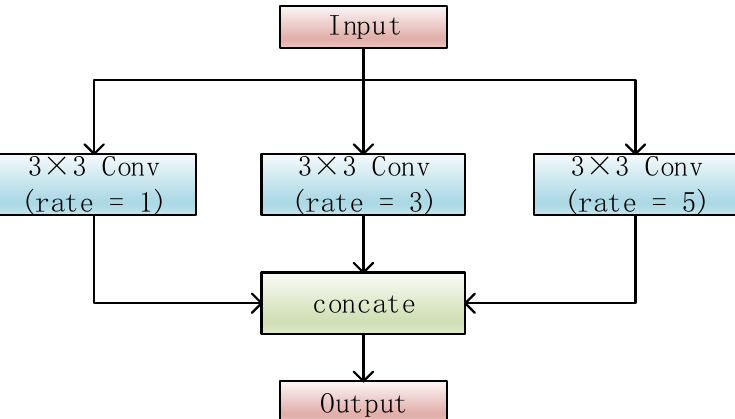
Figure 1. The structure of the multi-scale dilated convolution process.